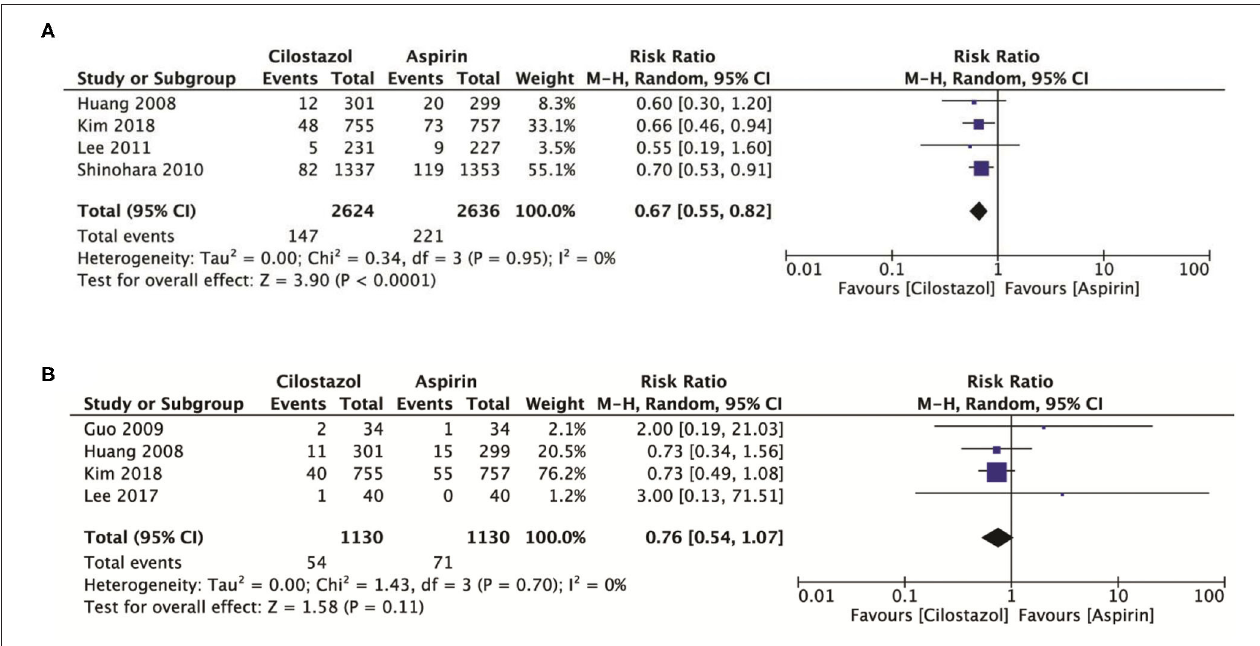
FIGURE 3 | (A) A forest plot of comparison: any stroke; (B) A forest plot of comparison: ischemic stroke.